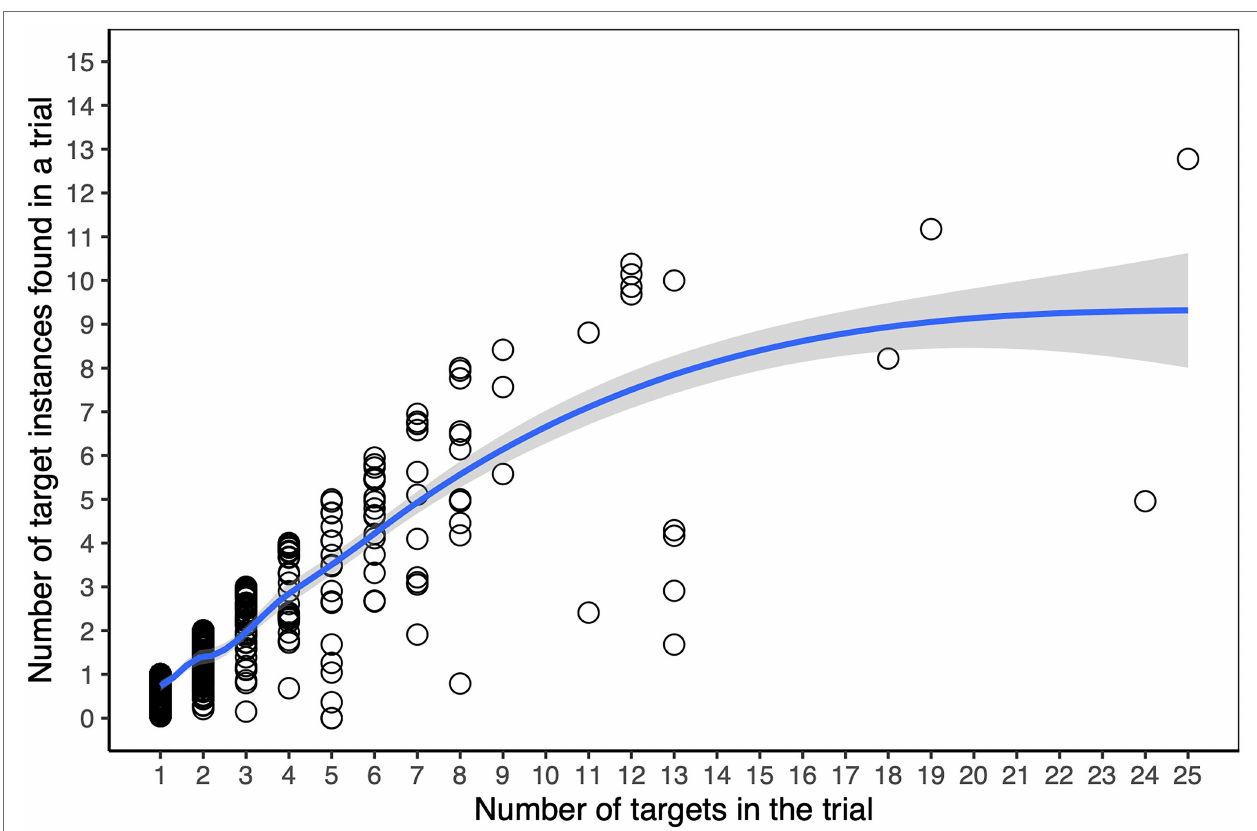
FIGURE 2 | Number of targets found in a trial vs. number of targets in the trial, Experiment 1. Each dot represents a given trial, and the y -axis indicates the average number of targets found (across participants) in that trial. The line is a loess